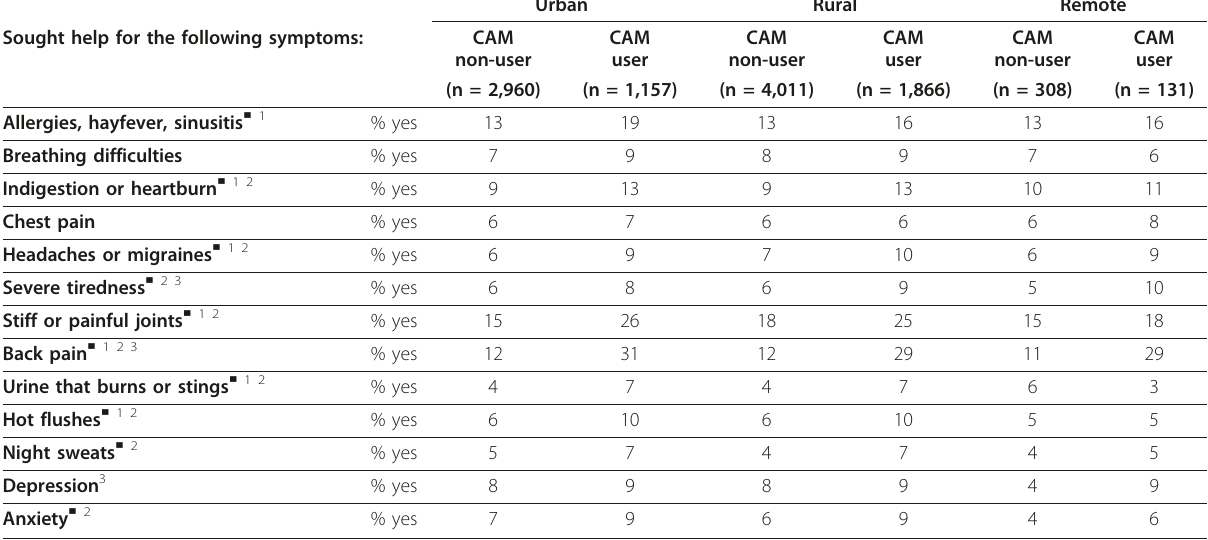
Table 3 Sought help for symptoms by CAM user status (consulted with a CAM practitioner or